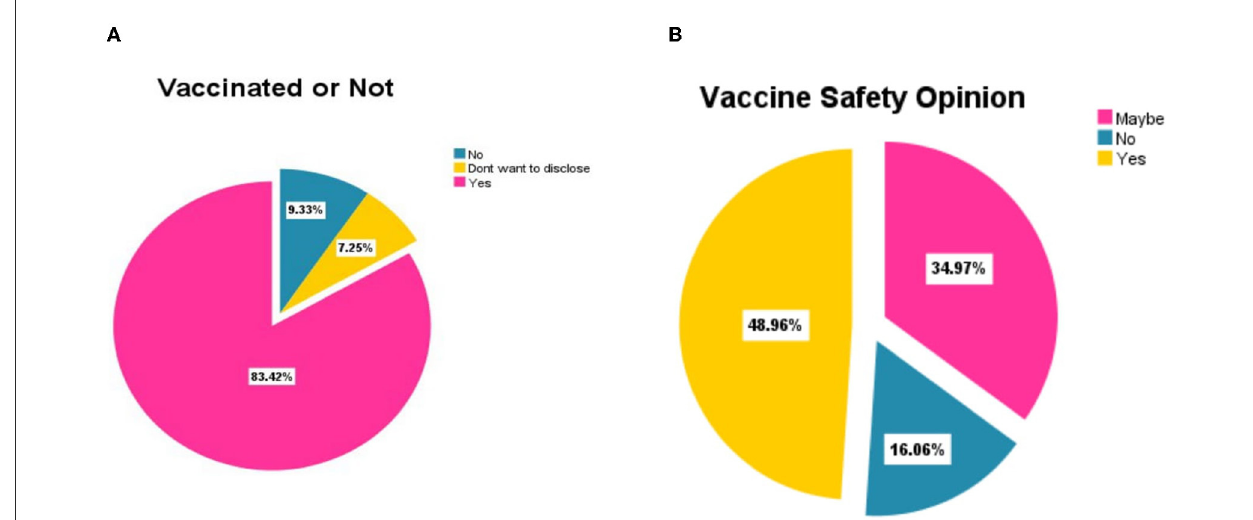
FIGURE4 Results of vaccination and vaccine safety opinion of the respondents ( N = 386). (A) Total respondents ( N = 386) vaccinated or not. (B) Total respondents ( N = 386) on vaccine safety opinion.